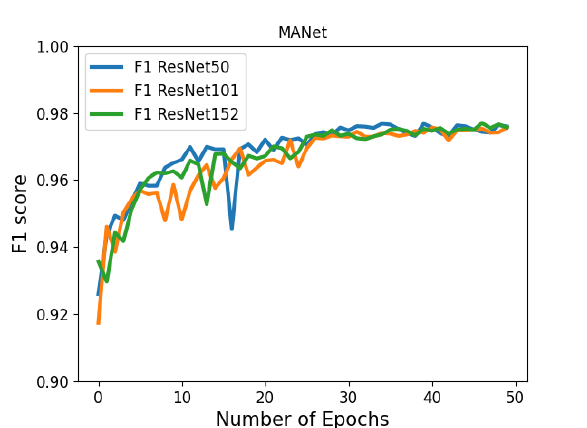
Figure 4 . F1 score for training with ResNet50(blue), ResNet101(orange), and ResNet152(green) for MANet